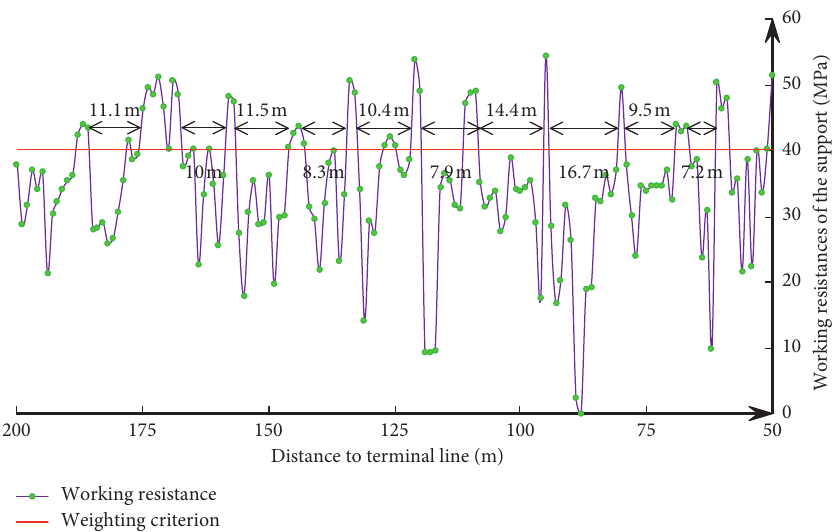
Figure 11: Working resistance curve of the support during the mining of the #4 coal